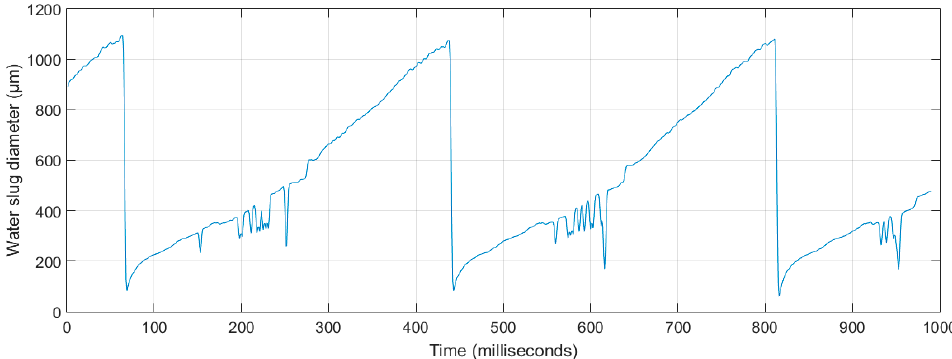
Figure 15. Dynamic evolution of slug diameter obtained from image processing.